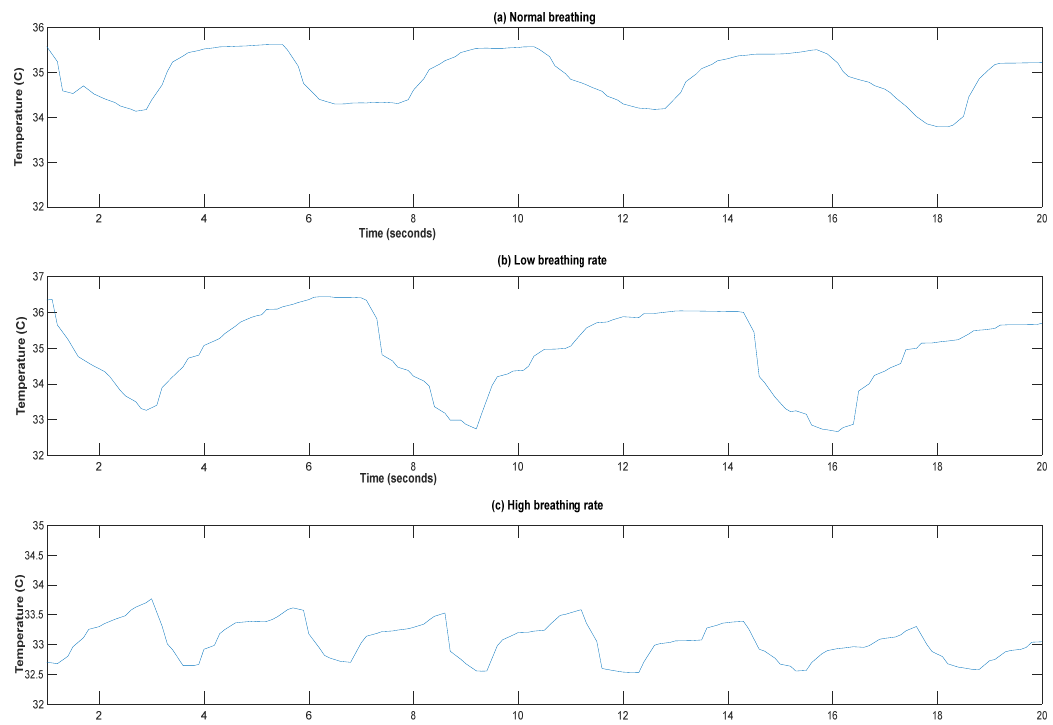
Figure 8. Respiration signal recorded at different rates: ( a ) normal breathing rate, ( b ) low breathing rate, and ( c ) high breathing rate.